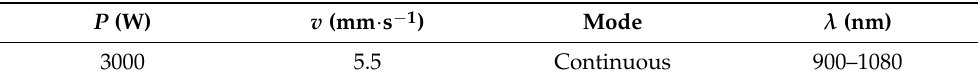
Table 2. Welding